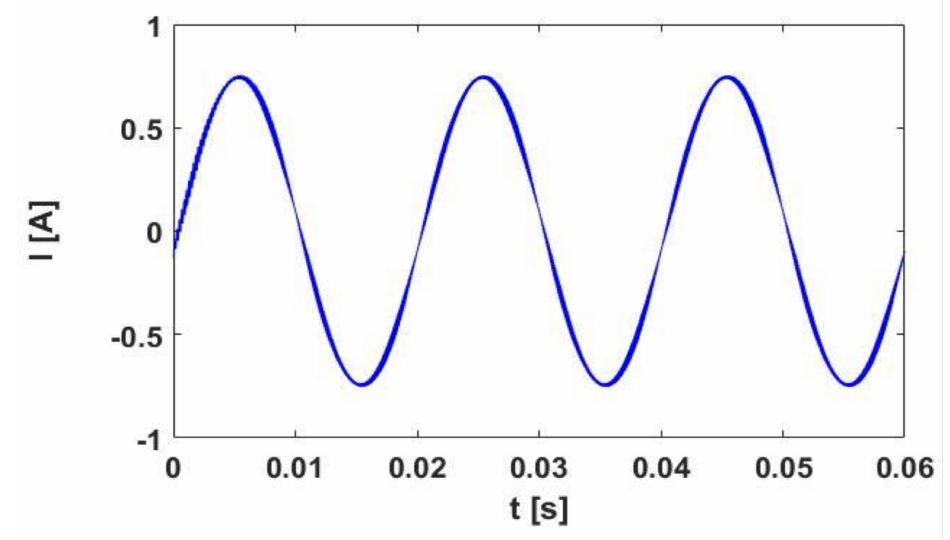
Figure 7. Input current waveform in the microinverter